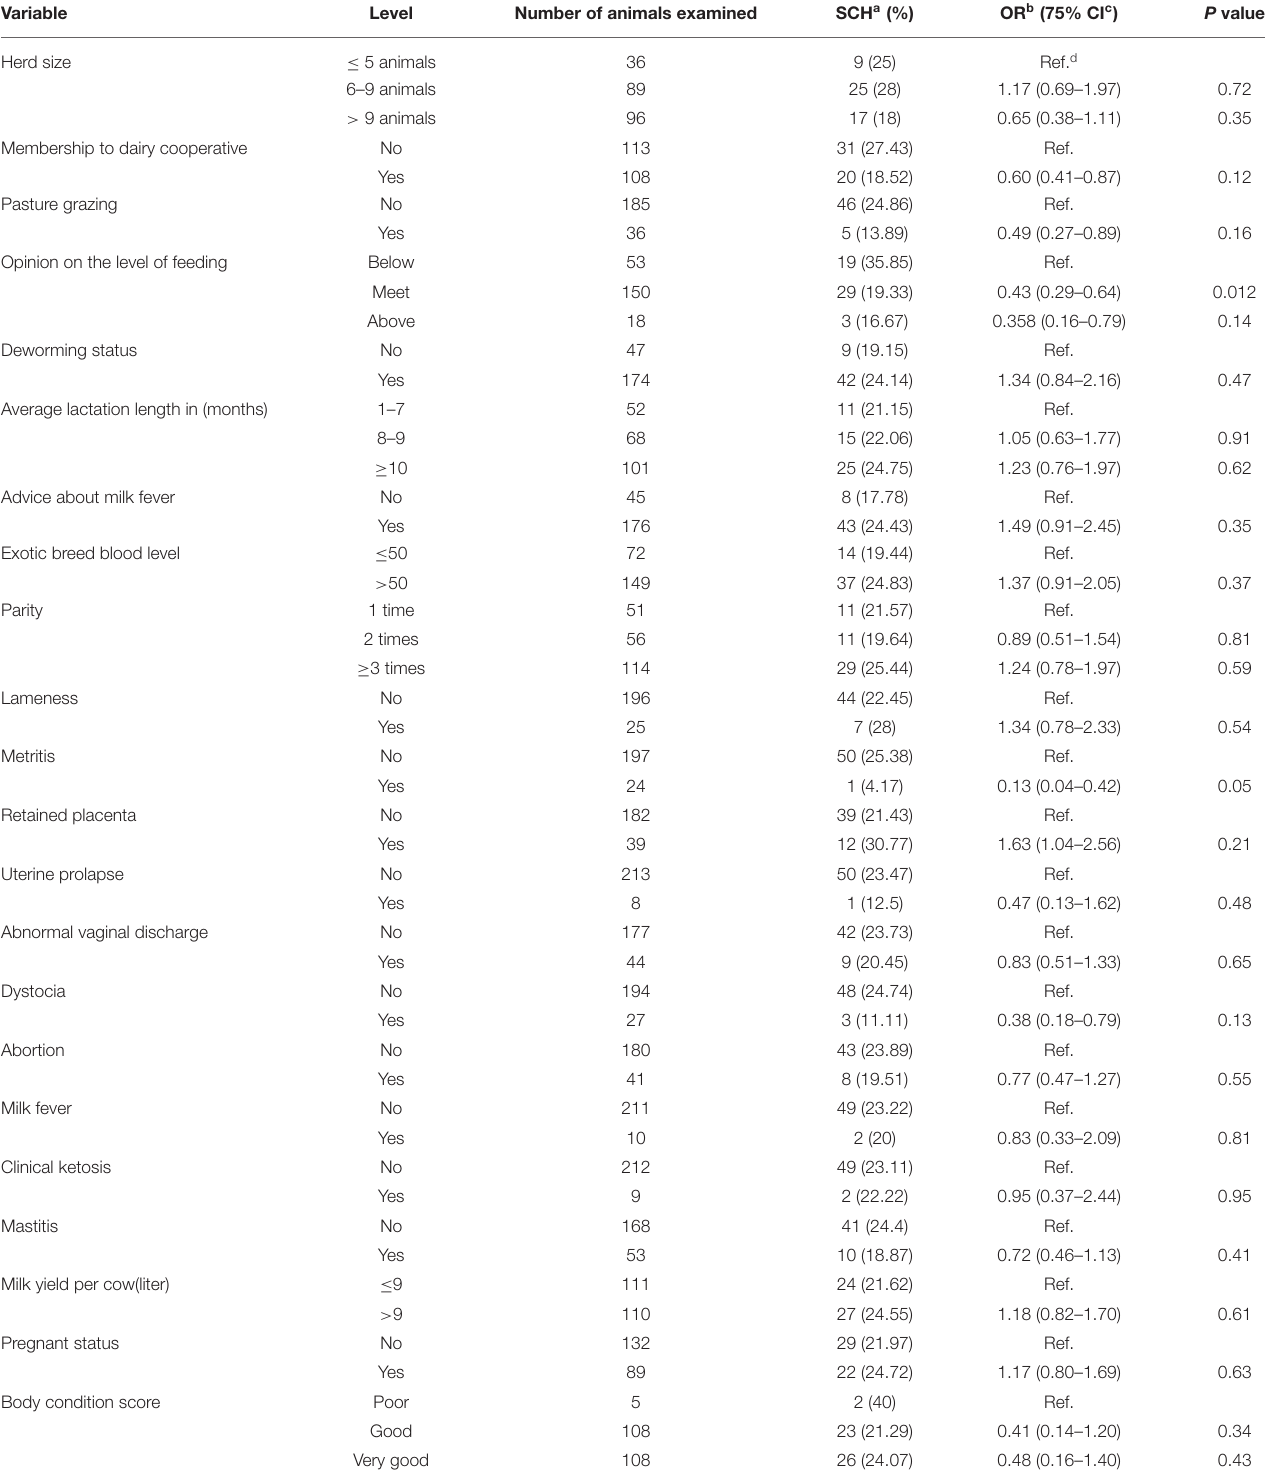
TABLE 3 | Descriptive statistics and univariate associations ( P < 0.025) between potential risk factors and subclinical hypocalcemia ( N = 221) with a random herd effect in dairy farms of North-West